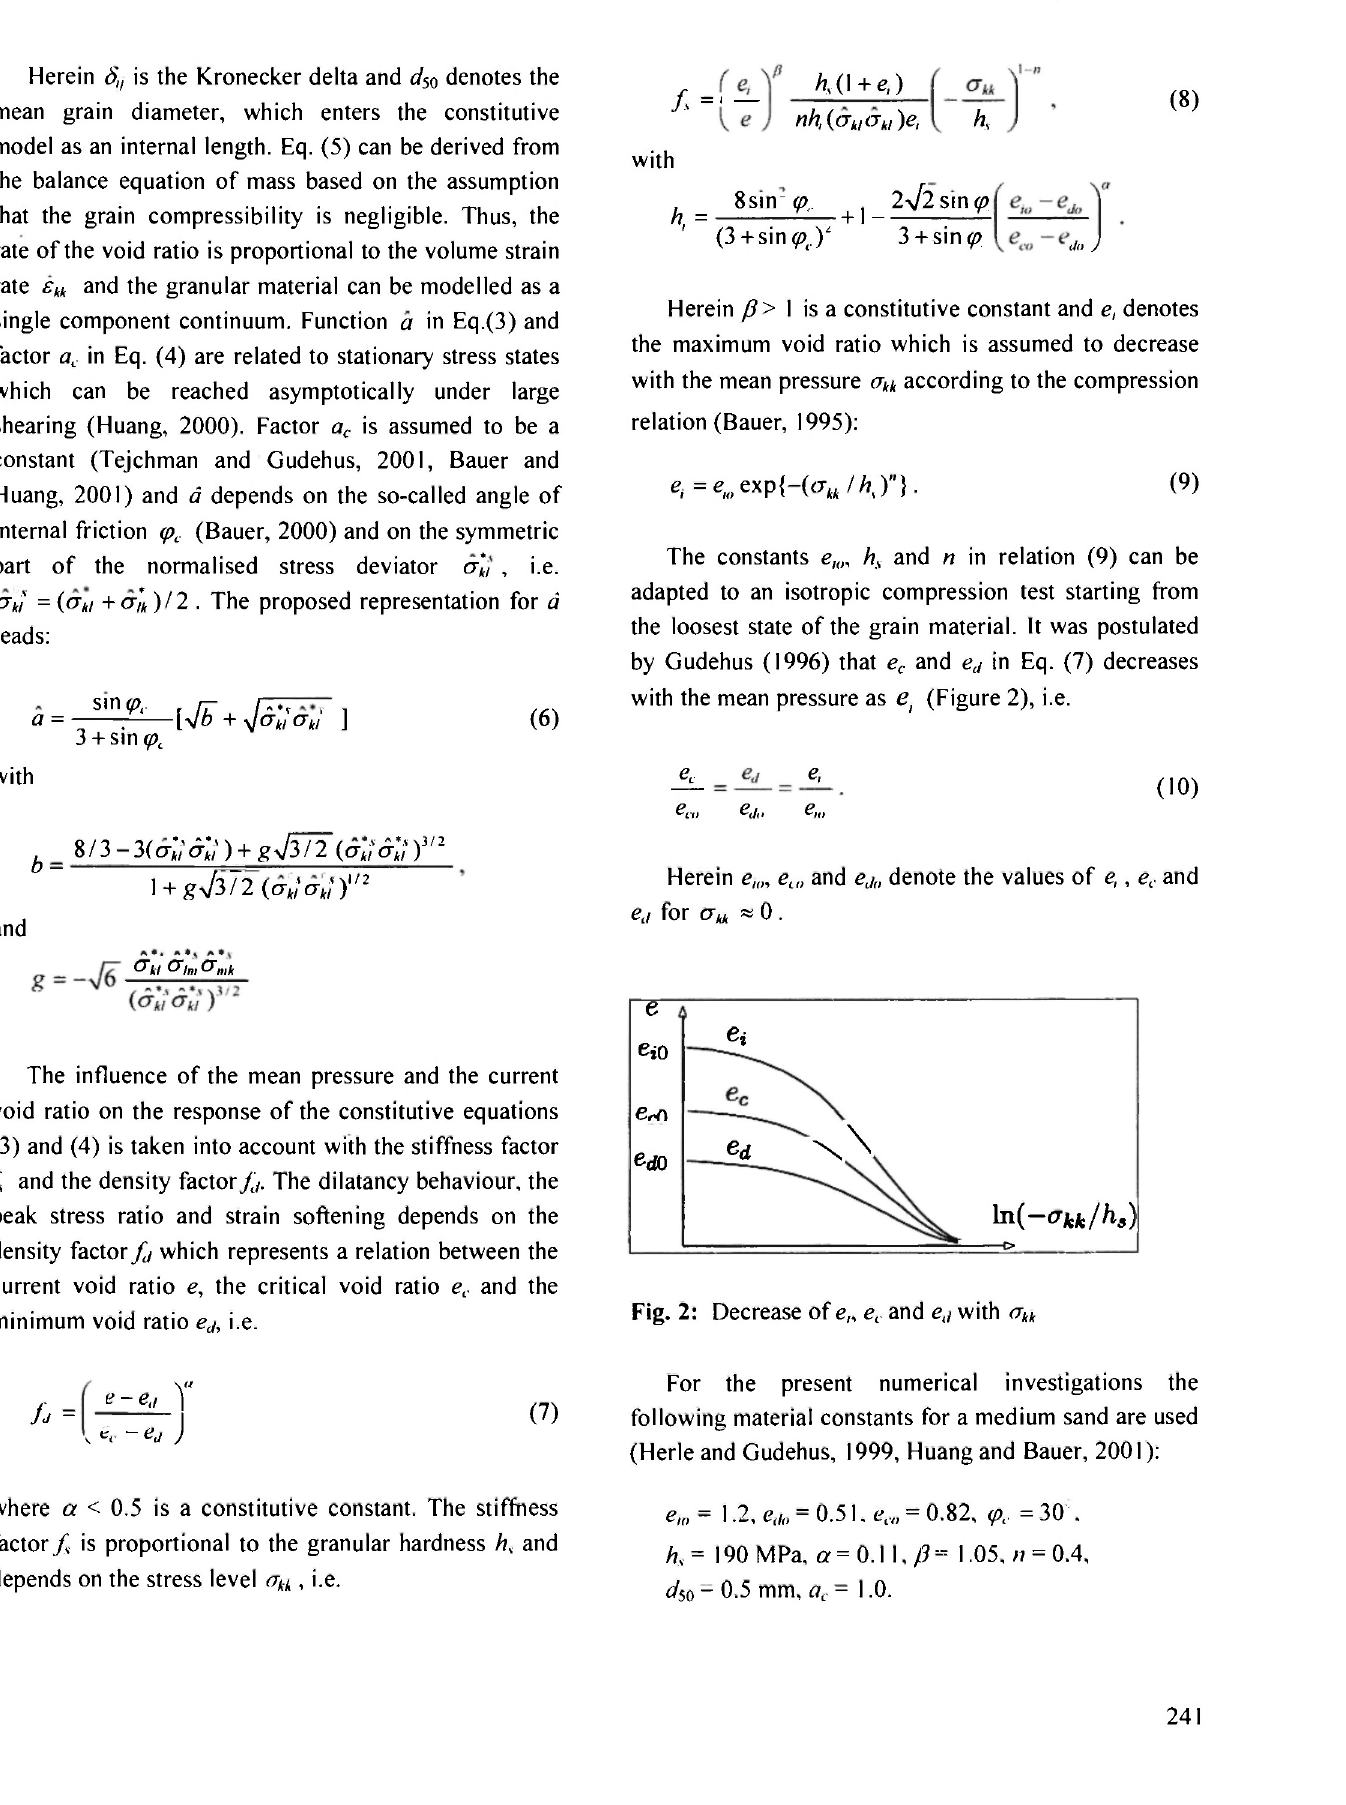
Fig. 2: Decrease of e„ e L and e lt with a kk